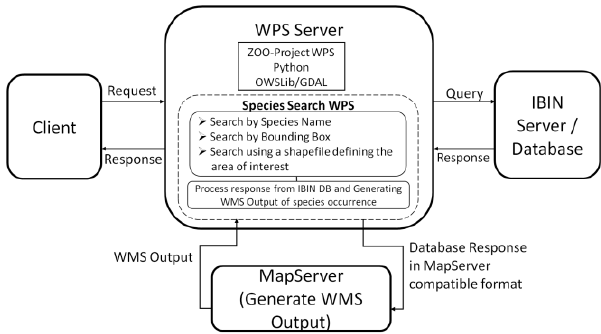
Figure 1. The overall architecture of the Species Search WPS